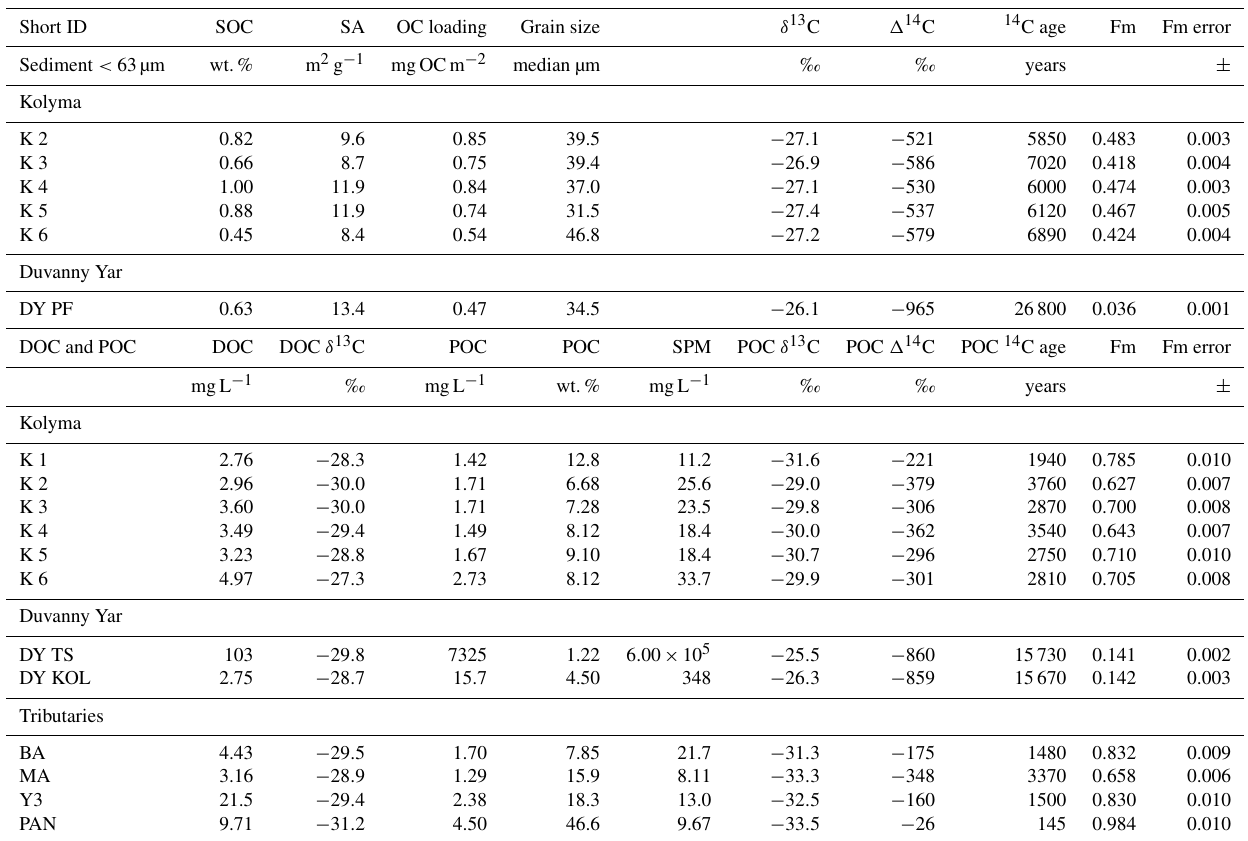
Table 2. Bulk data for sediment organic carbon (SOC), dissolved organic carbon (DOC), and particulate organic carbon (POC). Including concentrations, surface area (SA), organic carbon loading and isotopic data δ 13 C, (cid:49) 14 C, conventional, uncalibrated radiocarbon age (years), and fraction modern (Fm) with the measurement